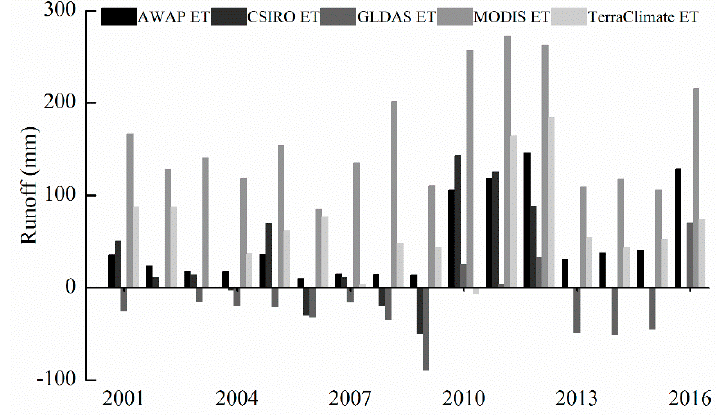
Figure 5. The yearly runoff estimations using different ET products.